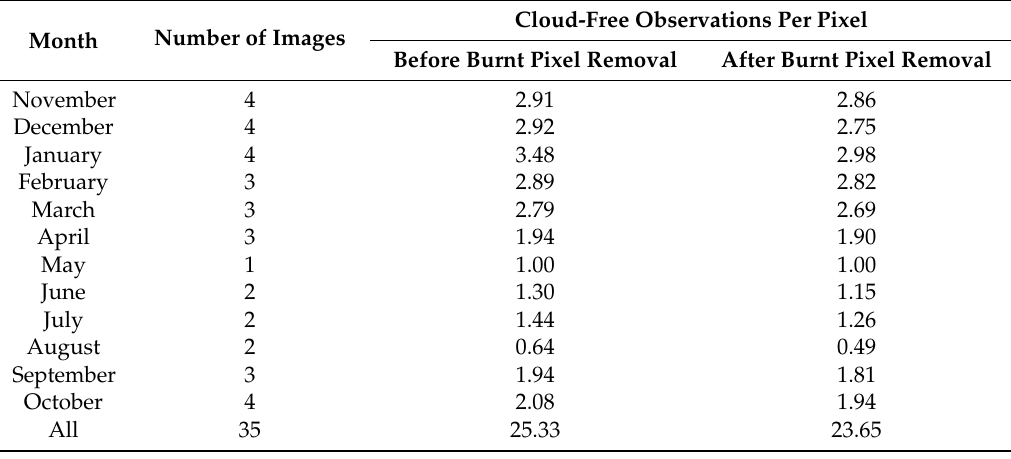
Table 1. Summary of the images and cloud-free observations per month and per